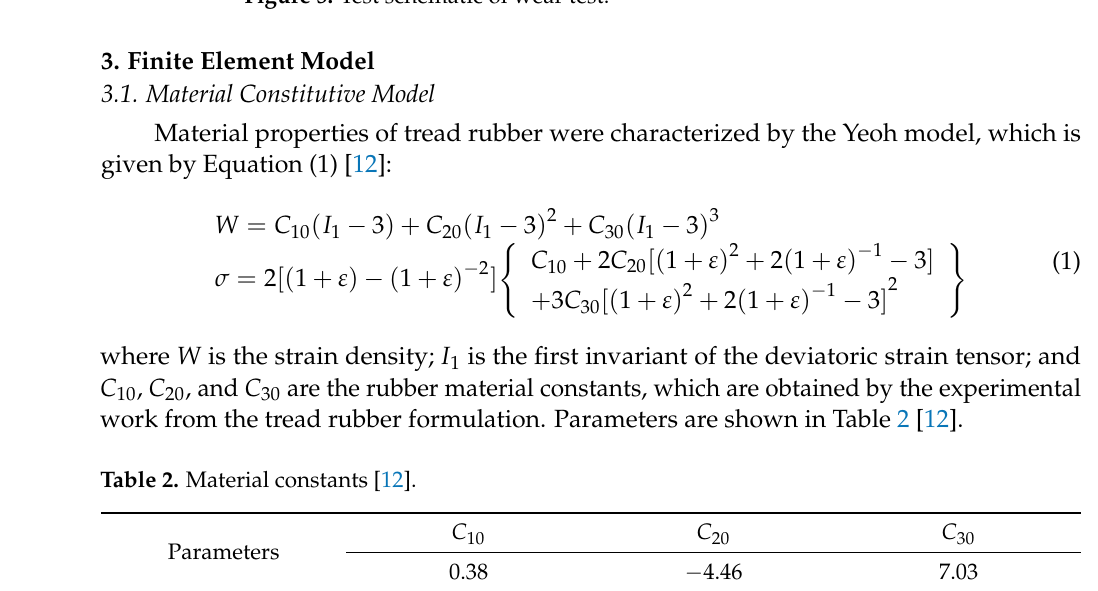
Figure 5. Test schematic of wear test.